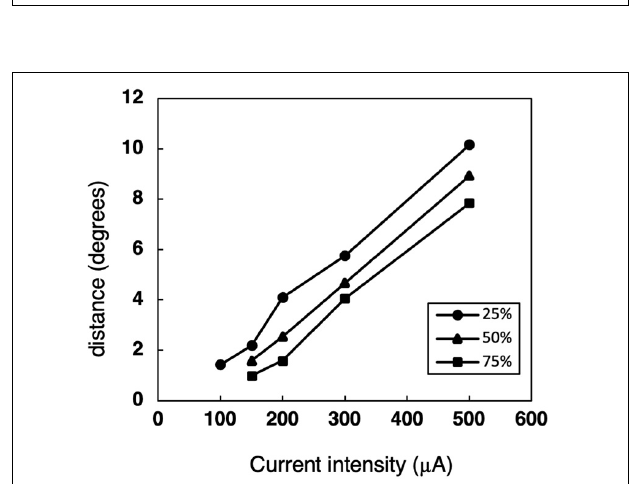
FIGURE 6 | The relationship between the distance and current intensity with 75, 50, or 25% response probability thresholds. The data was calculated from the median-distance graphs in Figure 4